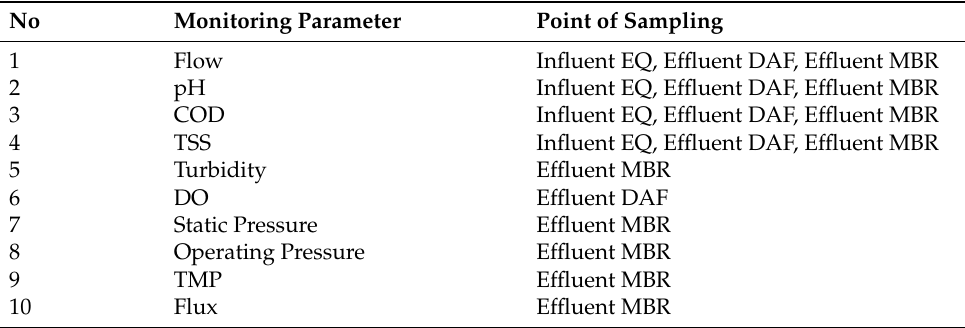
Table 2. The monitoring parameter and the sampling point.